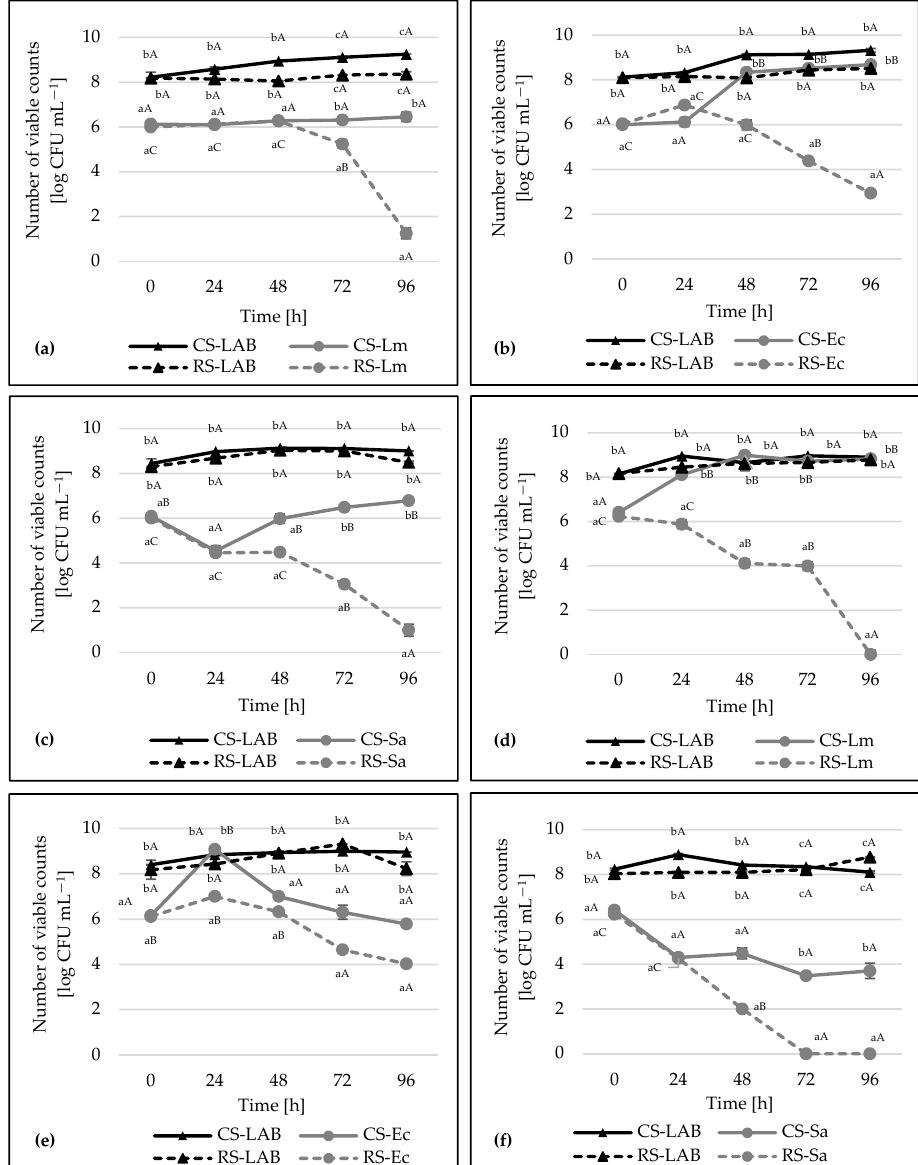
Figure 4. ( a ) Impact of Lb. plantarum SCH4 on the viability of L. monocytogenes ATCC 19111 in milk; ( b ) impact of Lb. plantarum SCH4 on the viability E. coli ATCC 10536 in milk; ( c ) impact of Lb. plantarum SCH4 on the viability of S. aureus ATCC 25923 in milk; ( d ) impact of Lb. plantarum BAL7 on the viability of L. monocytogenes ATCC 19111 in milk; ( e ) impact of Lb. plantarum BAL7 on the viability of E. coli ATCC 10536 in milk; ( f ) impact of Lb. plantarum BAL7 on the viability of S. aureus ATCC 25923 in milk; explanatory: CS-LAB—control sample, Lb. plantarum SCH4 or BAL7; RS-LAB—research sam- ple, Lb. plantarum SCH4 or BAL7; CS-Lm—control sample, L. monocytogenes ATCC 19111; RS-Lm—research sample, L. monocytogenes ATCC 19111; CS-Ec—control sample, E. coli ATCC 10536; RS-Ec—research sample, E. coli ATCC 10536; CS- Sa—control sample, S. aureus ATCC 25923; RS-Sa—research sample, S. aureus ATCC 25923; the graph shows the log bac- terial cell count (CFU mL − 1 ) with standard deviation. Means in the same row followed by different uppercase letters within the same sample in different times are significantly different ( p < 0.05); means in the same column followed by different lowercase letters within samples in the same time are significantly different ( p < 0.05).